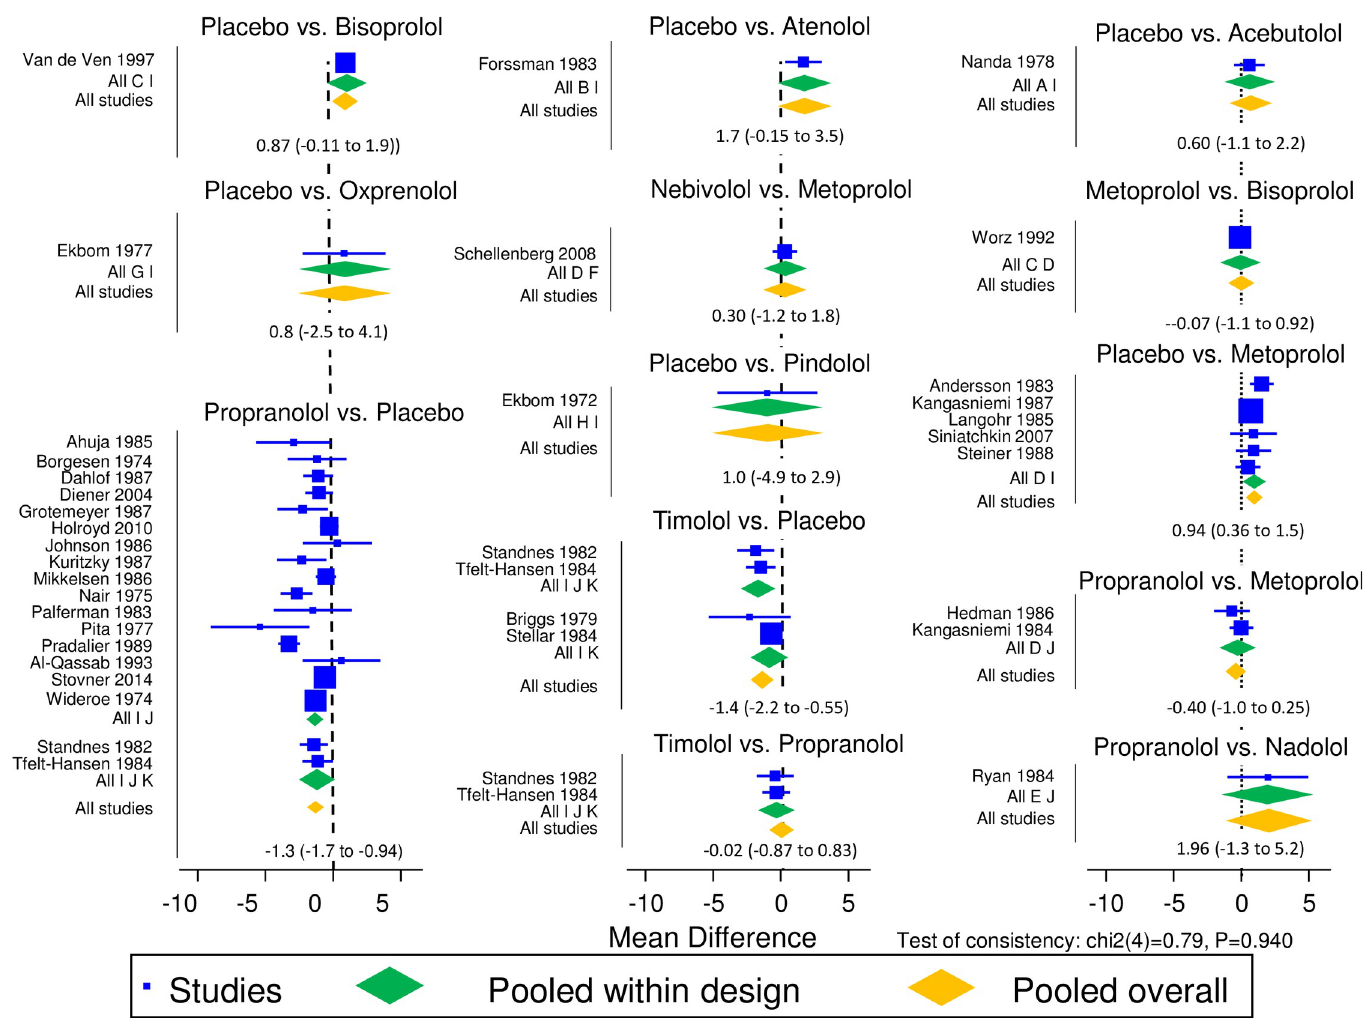
Fig 6. Results of network meta-analysis